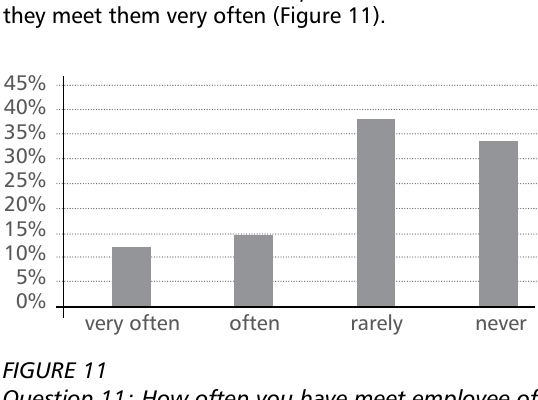
Question 10: At which management stage employees in PEMF are involved in illegal activities?